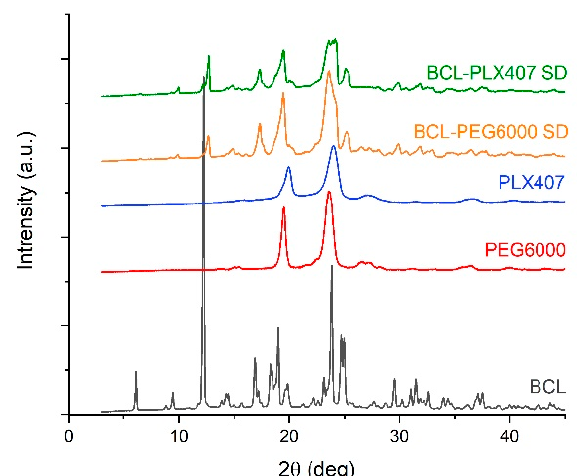
Figure 4. X-ray diffraction of raw bicalutamide and carriers, i.e., Macrogol 6000 and Poloxamer ® 407, and solid dispersions.